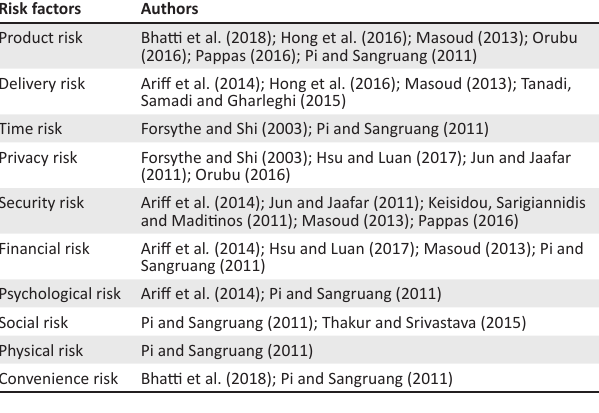
TABLE 1: Summary of studies about risk factors in online shopping. Risk factors